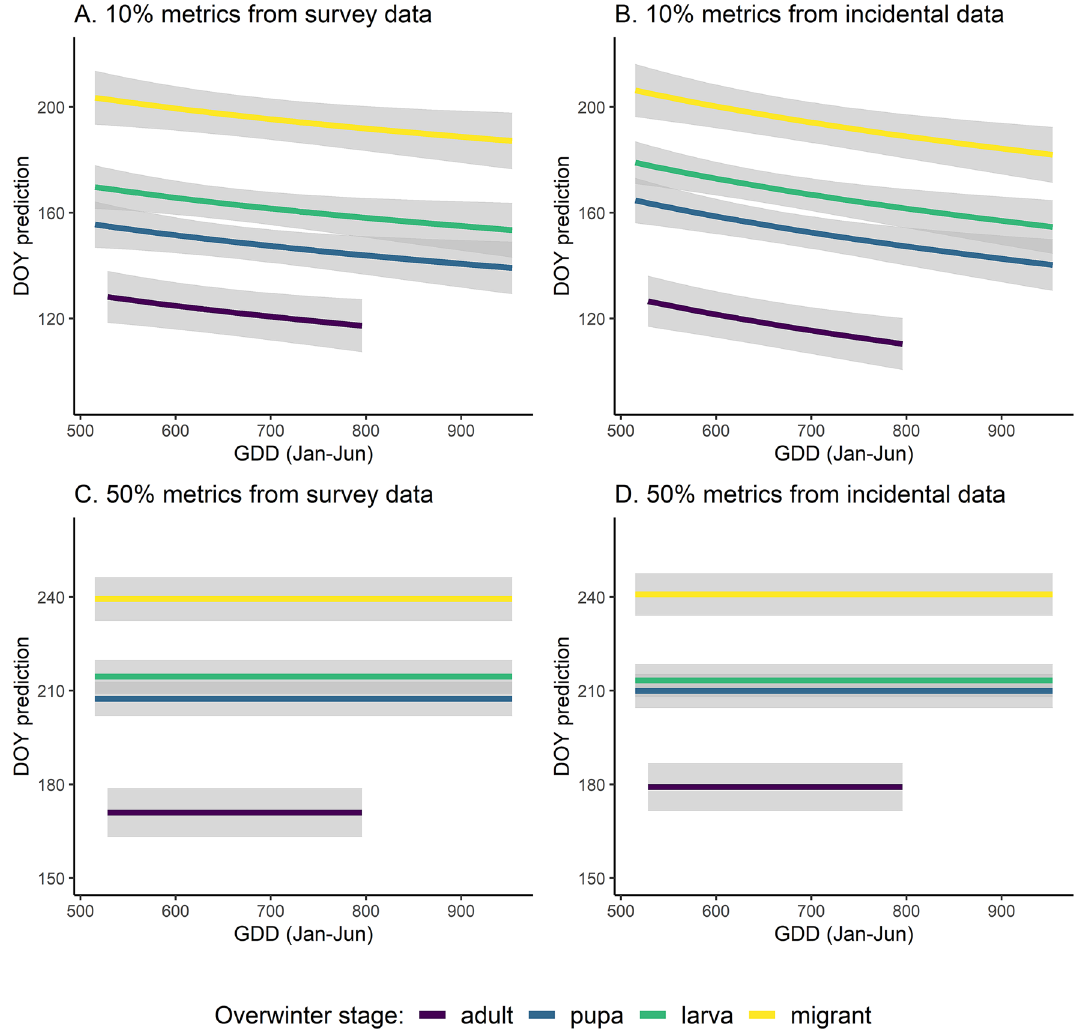
Figure 3. Model predictions for expected day-of-year (DOY) of early-season (10%) and mid-season (50%) phenology across species based on temperature (GDD) and overwinter strategy (by color: migrant species, and resident species overwintering as adults, pupae, larvae). Linear effect of log(GDD) shown on GDD axis. Model parameter estimates are in Table